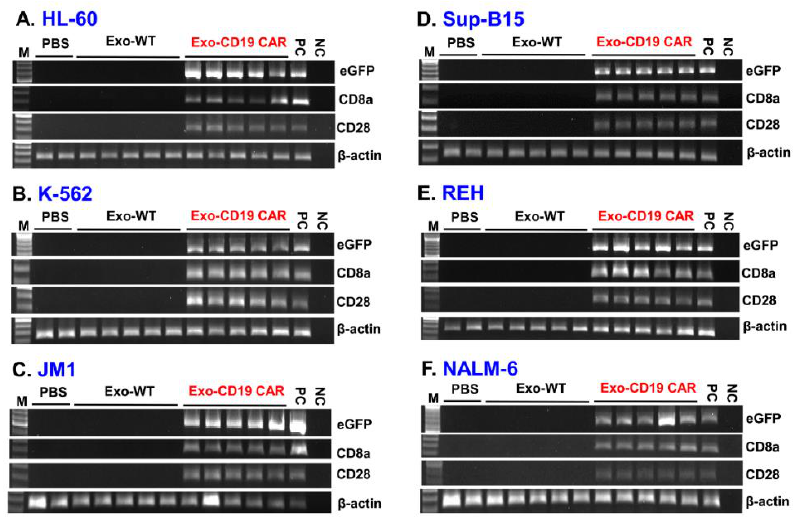
Figure 5. Delivery of Exo-CD19 CAR molecules into the target cells. Agarose gel shows eGFP, CD8a, and CD28 mRNA expression (CAR plasmid markers) in each of the target cells lines. ( A ) HL-60, ( B ) K-562, ( C ) JM1, ( D ) Sup-B15, ( E ) REH, ( F ) NALM-6. The β -actin is used as an endogenous control. Five different batches of exosomes (Exo-WT and Exo-CD19 CAR) were used in the experiments ( n = 5). Densitometry of the gels are included as a supplementary figure (Supplemental Figure S3).